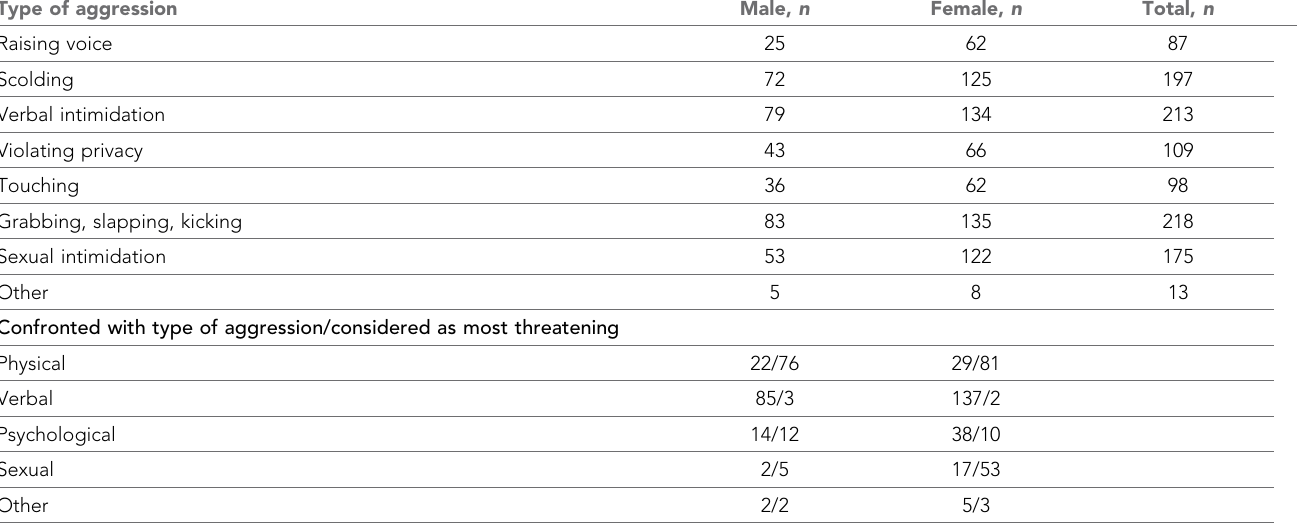
Table 3. Types of aggression, as experienced by GPs. Frequency of GPs experiencing aggression type versus frequency of considering it the most threatening type of